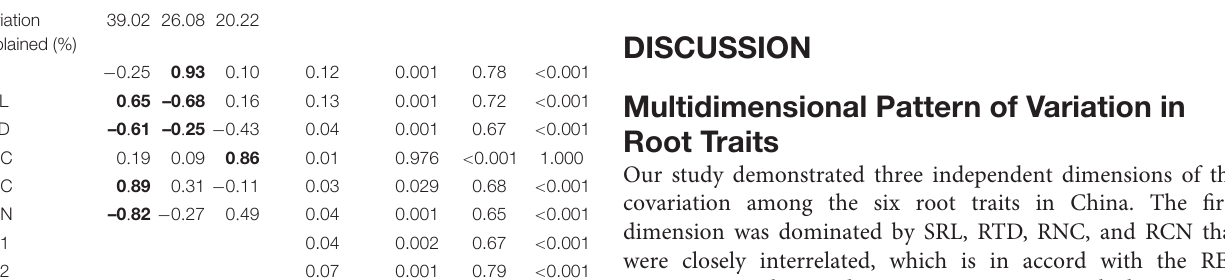
Frontiers in Plant Science |